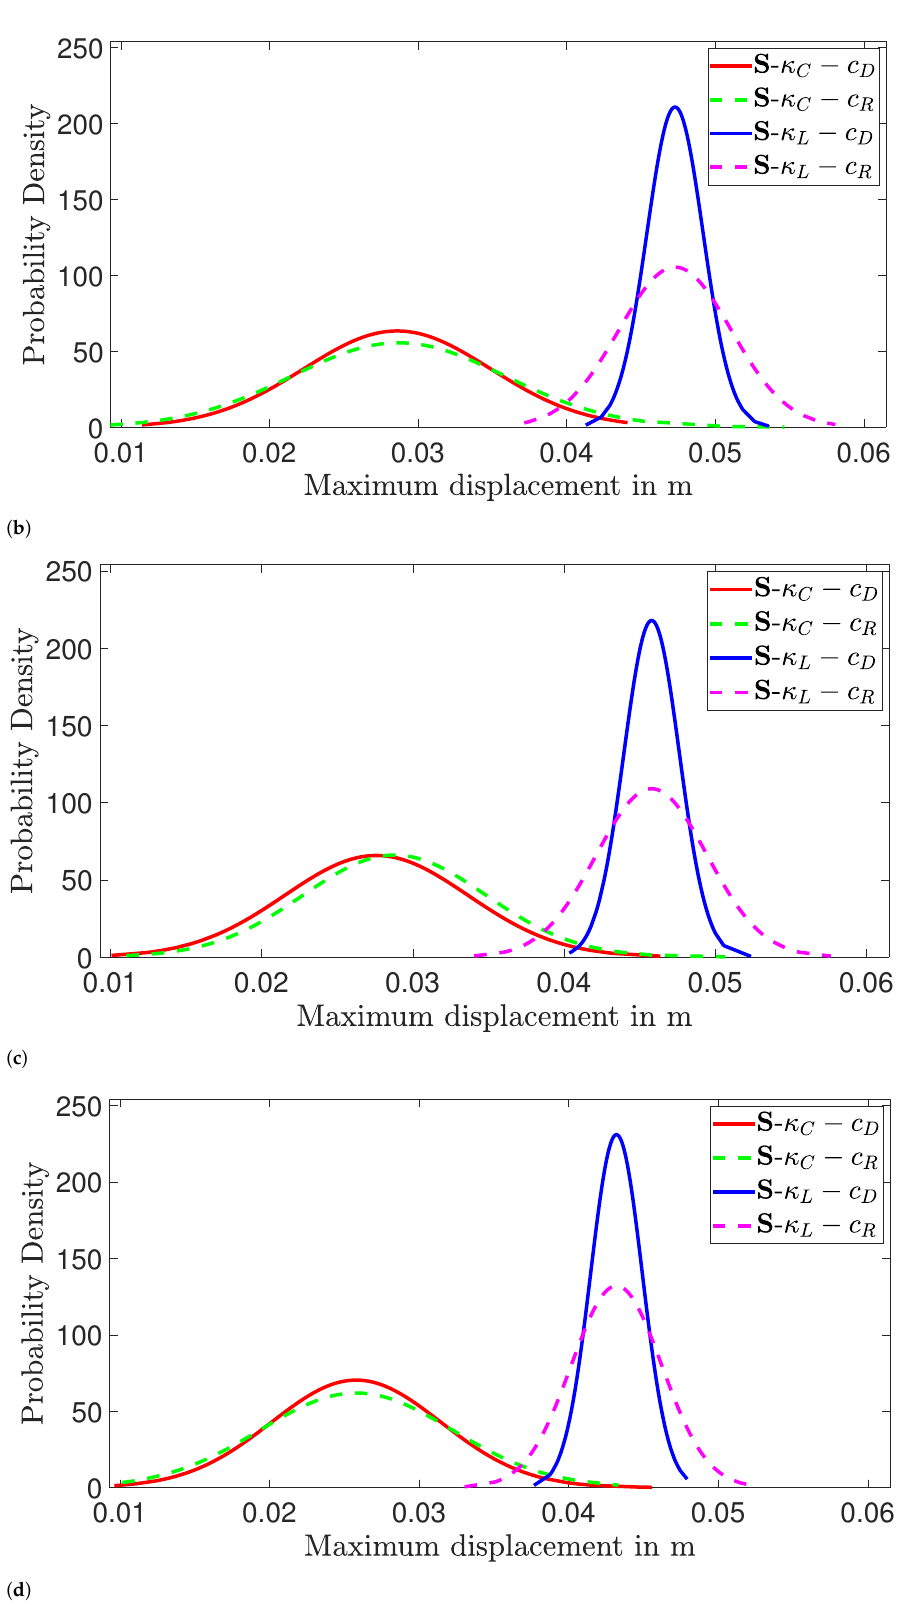
Figure A2. PDFs of the maximum displacement in m for non-porous medium. κ L , κ C stands for the linear and constant distribution for κ , respectively, and c D , c R stands for the deterministic and random distribution for c, respectively. Subplot ( a – d ) stand for eccentricity 0, h